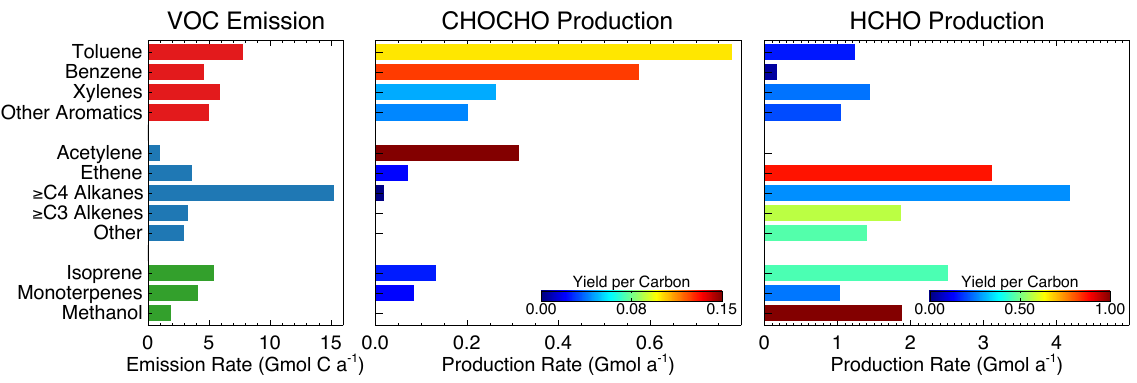
Figure 2. Yearly VOC emissions (2006) in the PRD (21.5–24 ◦ N, 112–115.5 ◦ E) and corresponding yields and production rates of CHOCHO and HCHO over 1 day of aging. VOC emissions are from Zheng et al. (2009a). Yields are computed using the MCMv3.2 chemical mechanism (Jenkin et al., 1997,